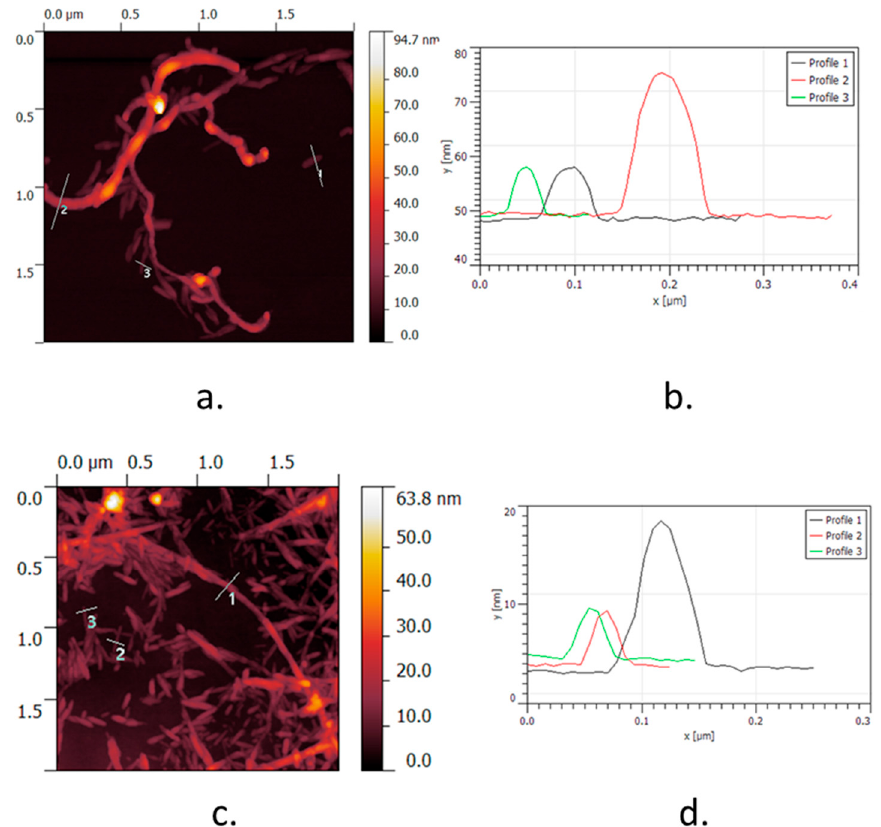
Figure 3. ( a , b ) Atomic force microscope height image of the MWNT / CNC complex and its associated height profiles. ( c , d ) Atomic force microscope height image of the SWNT / CNC complex and its associated height profiles.